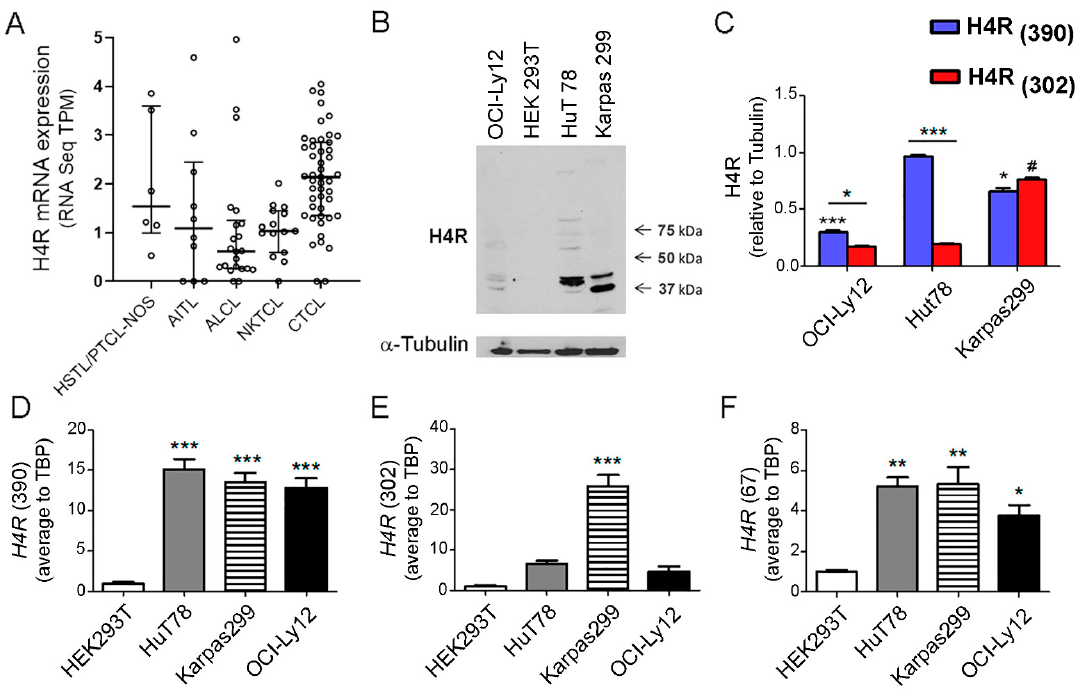
Figure 1. H4R expression in TCL. ( A ) H4R mRNA expression (ENST00000256906.5 transcript variant 1, full length) in tumors of TCL patients. The transcriptional datasets of tumors from patients with